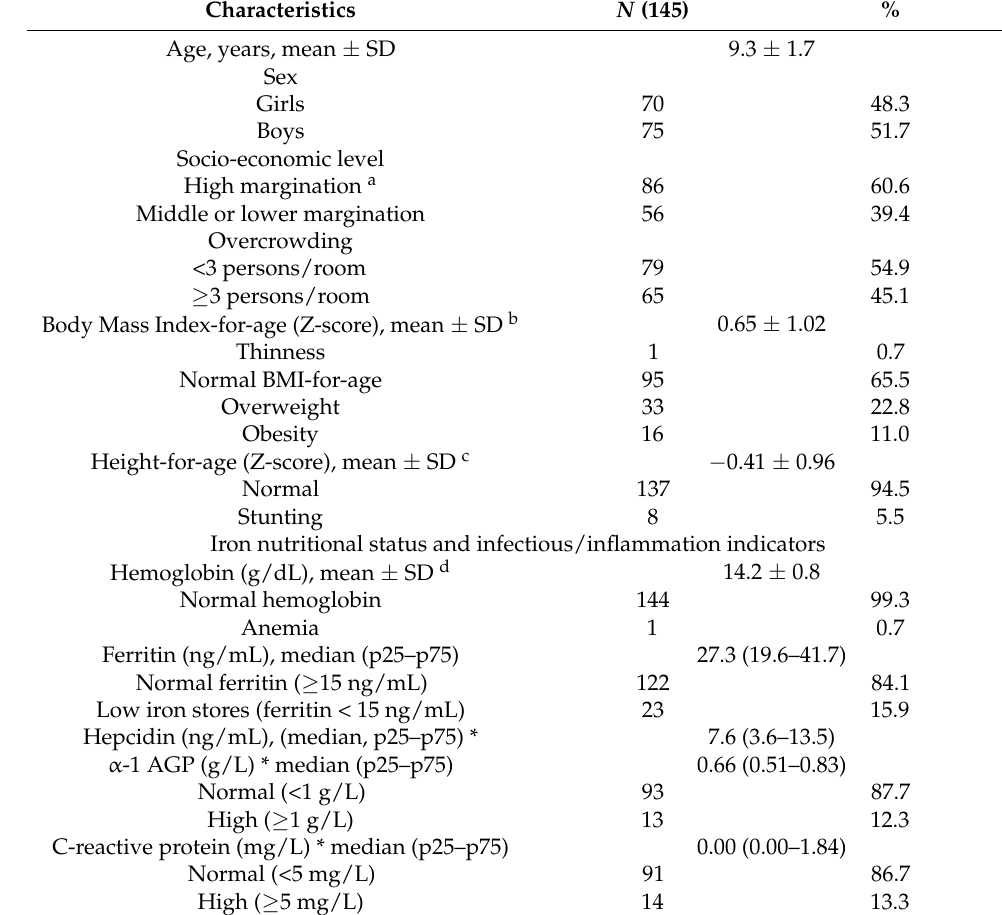
Table 1. Characteristics of study